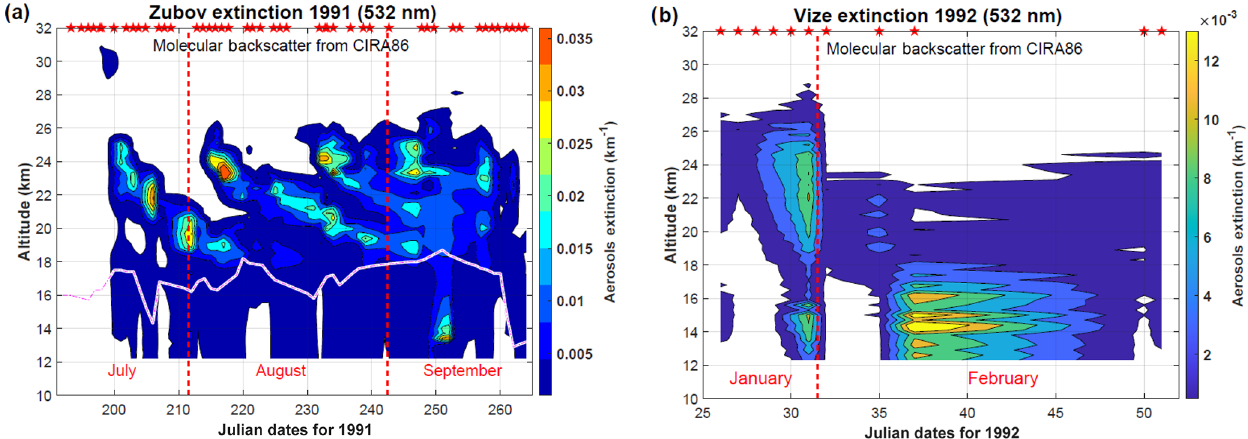
Figure 2. Temporal–vertical cross sections of the aerosol extinction at 532nm measured by the lidar on board the two shipborne lidars during their trajectories: (a) Professor Zubov ship and (b) Professor Vize